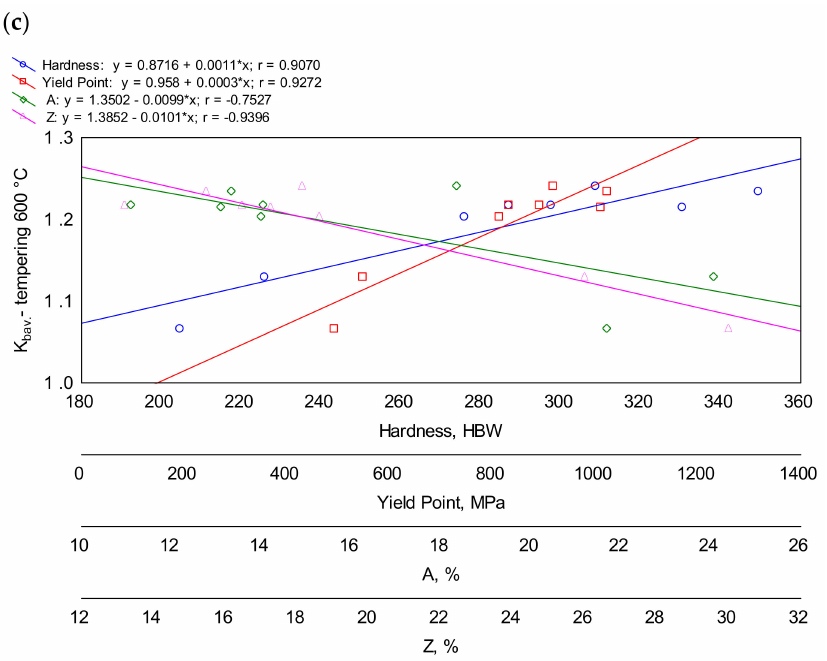
Figure 17. Correlations between abrasive wear resistance index K b and the hardness, yield point, elongation and area reduction after fracture of the analyzed cast steels after quenching and tempering: ( a ) at 200 ◦ C; ( b ) at 400 ◦ C; ( c ) at 600 ◦ C.